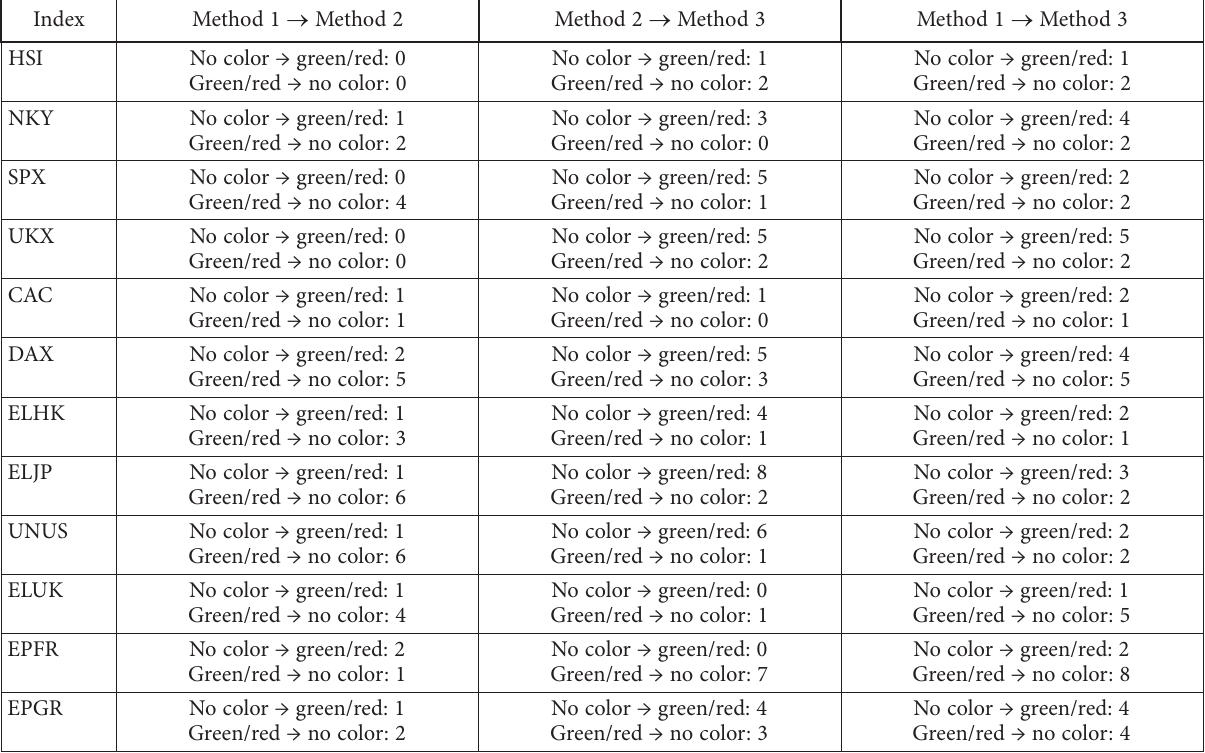
Table 8. Change in number of green and red entries between the three methods for the 12 stock indices Index